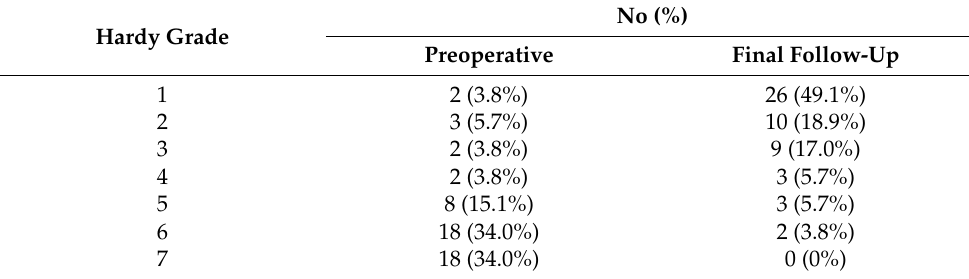
Table 4. Distributions of the positions of the medial sesamoid (Hardy grade).